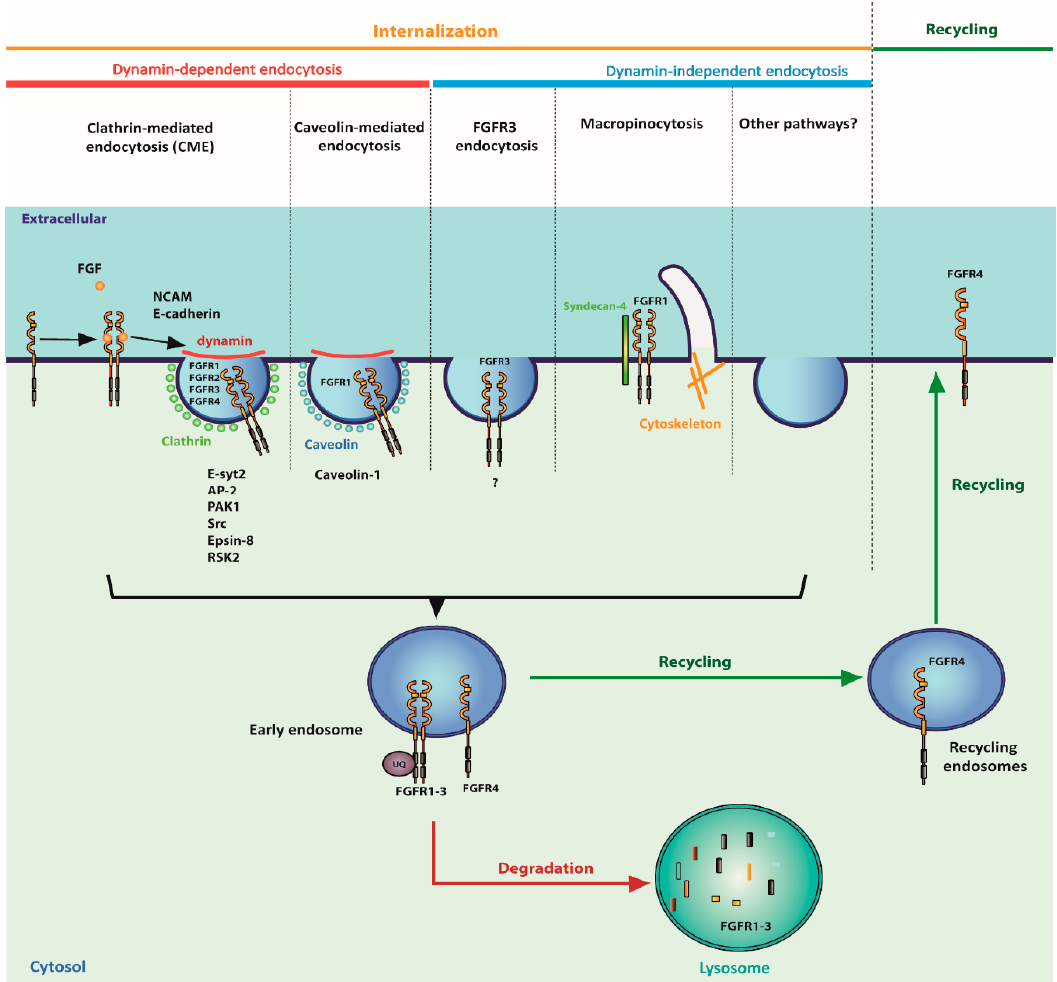
Figure 4. Internalization and cellular trafficking of FGFRs. FGFRs are internalized via diverse endocytic mechanisms. The selection of an internalization pathway depends on the receptor type and is modulated by the partner proteins. After internalization, FGFRs are sorted into endosomes, where they can be directed either to lysosomal degradation (mainly FGFR1-3) or recycled to the plasma membrane (FGFR4). The receptor ubiquitination decides about the intracellular sorting of endocytosed FGFRs.